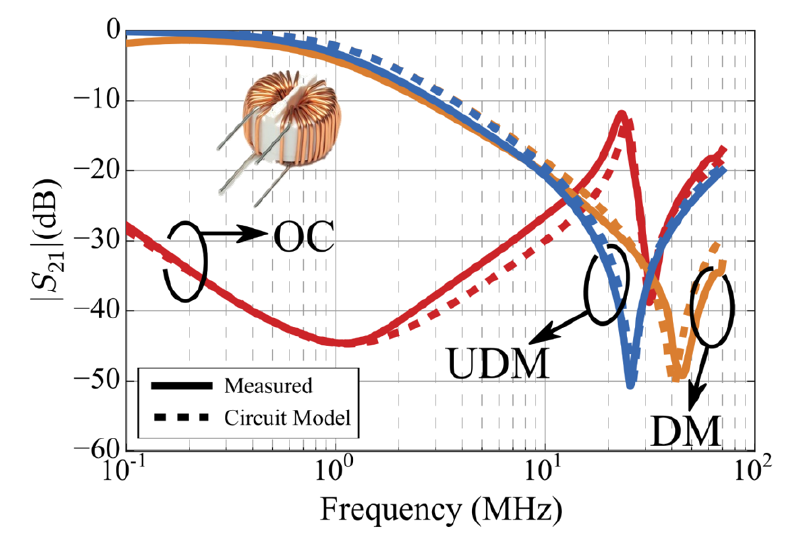
Figure 9. Magnitude | S 21 | for the CMC listed as KEMET SC-02-30G (3 mH) in Table 2, using the setups in Figures 3 and